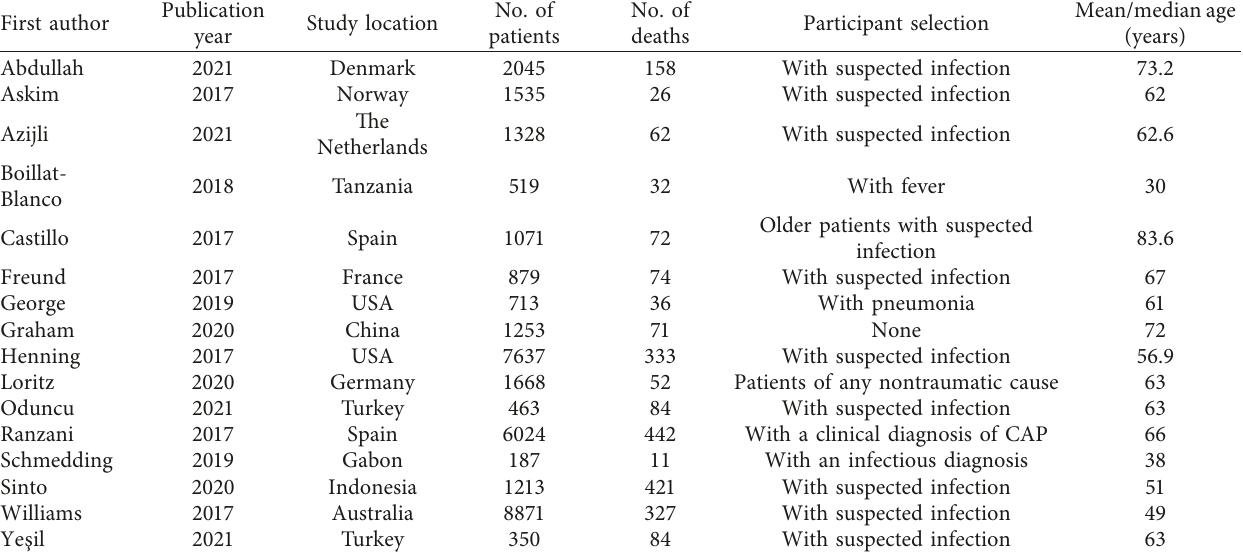
Table 1: Characteristics of included